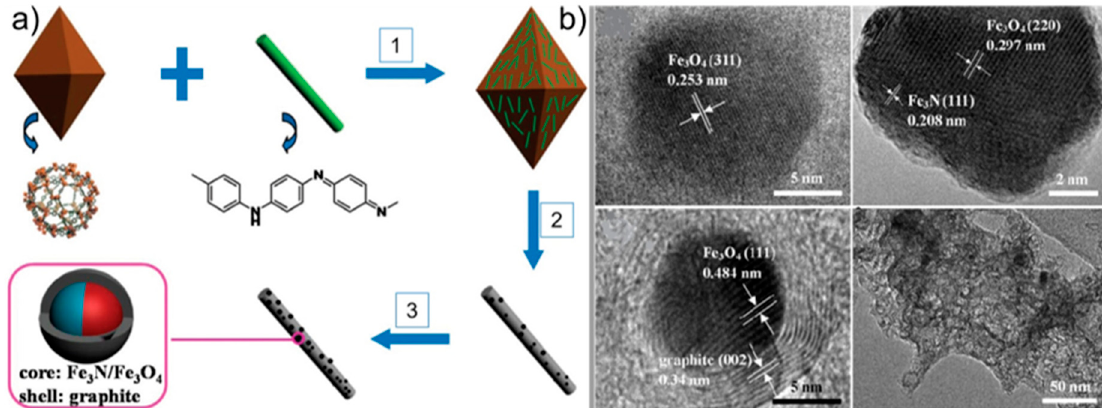
Figure 17. ( a ) Schematic preparation of the C-MIL-101 / PANI-8 catalyst obtained by (1) mixing of MIL-101(Fe) MOF with PANI, (2) first heat treatment under N 2 , and (3) acid leaching followed by second heat treatment. ( b ) HR-TEM images of the C-MIL-101 / PAni-8 catalyst. Reprinted and modified with permission from ref. [128]. Copyright (2018) Royal Society of Chemistry. MIL: Materials of Institut Lavoisier (MOF class), PANI: